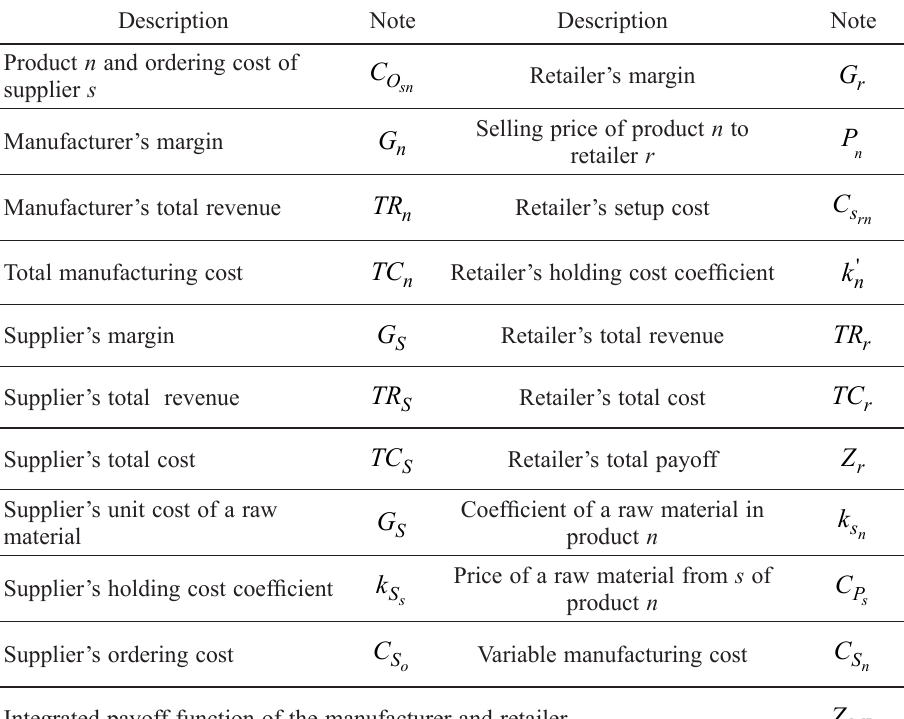
Table 2. The notation of decision variables and